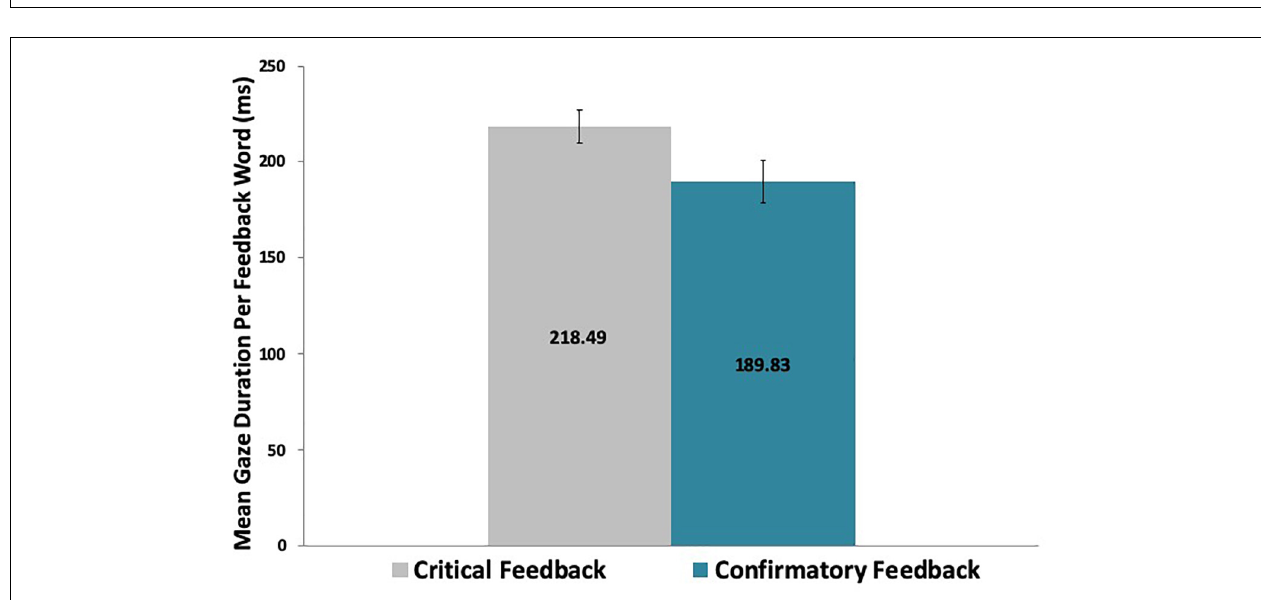
FIGURE 5 | Participants spent significantly more time dwelling on critical than on confirmatory feedback words across the game.